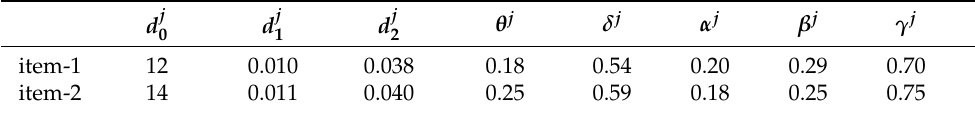
Table 3. Input data for the different type of parameters.